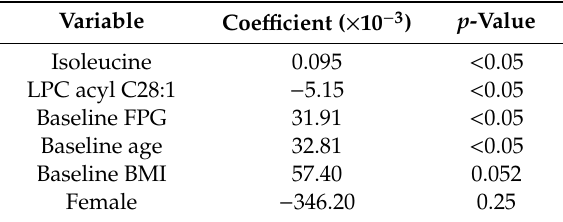
Table 6. Robust regression model showing the independent influence of isoleucine and lysophosphatidylcholine (LPC) acyl C28:1 on hemoglobin A1c 5 years